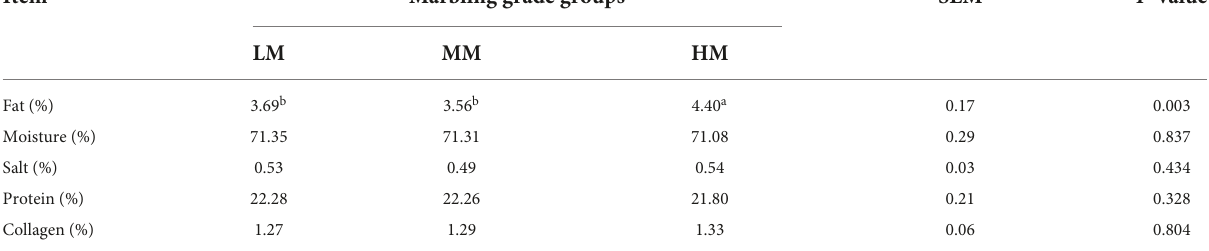
TABLE 2 The different analysis with the muscle chemical composition of meat and marbling